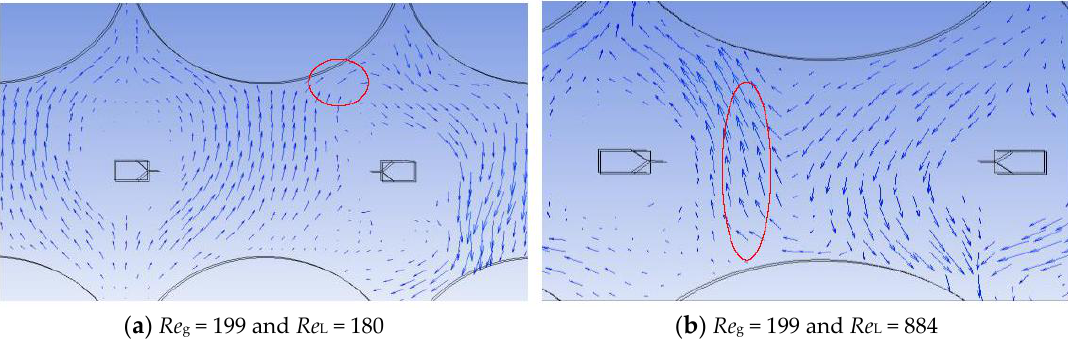
Figure 9. Gas and liquid velocity vectors.